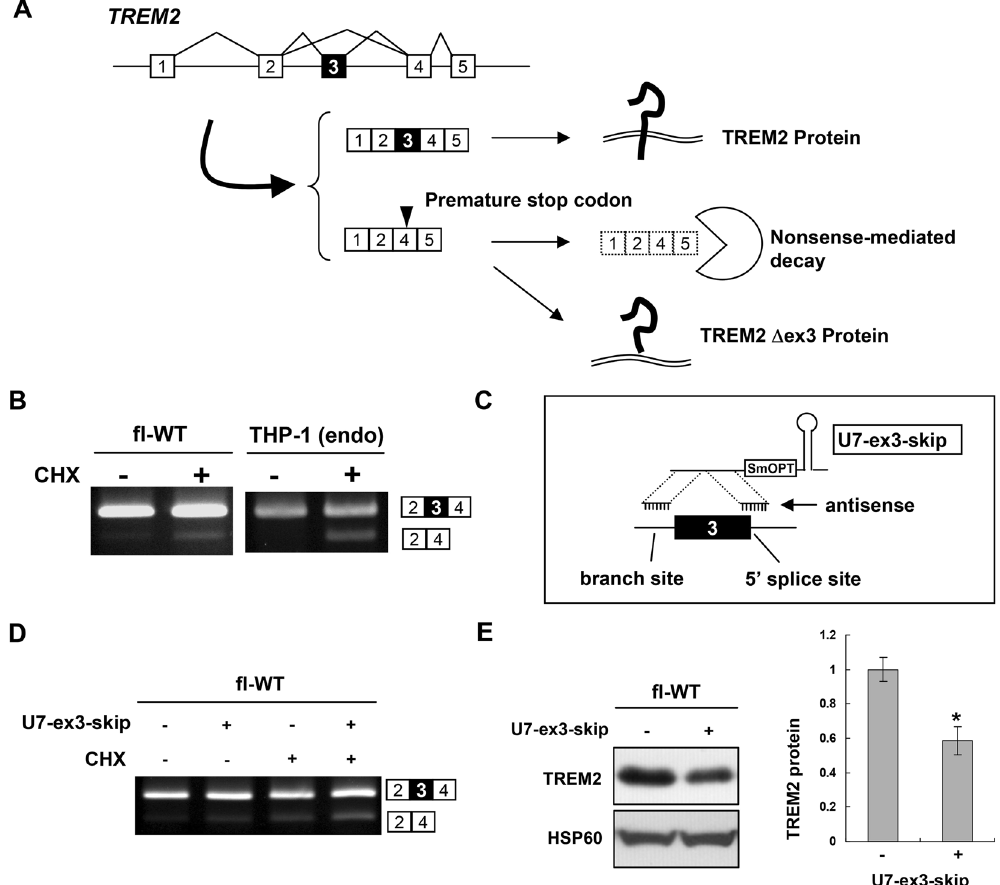
Figure 5. Exon 3 splicing of TREM2 is a determinant of its protein expression. ( A ) Schematic model of TREM2 exon 3 splicing. Exon 3 inclusion leads to expression of full-length TREM2 protein. Exon 3 skipping would result in either expression of a TREM2 isoform lacking exon 3 or degradation of mRNA via nonsense- mediated mRNA decay (NMD) due to production of a premature termination codon in exon 4. ( B ) Exon 3 is alternatively spliced in THP-1 cells. The splicing patterns of TREM2 in fl-WT and THP-1 cells with or without cycloheximide treatment, an NMD inhibitor, are shown. ( C ) Schematic illustration of U7-ex3-skip containing antisense sequences to both the branch point of intron 2 and exon/intron junction of exon 3. ( D ) fl-TREM2 (WT) cells were treated with U7-ex3-skip and/or CHX and the splicing patterns were analyzed by RT-PCR. The exon 3-skipped pattern was increased by U7-ex3-skip and further enhanced by CHX, suggesting that some of the spliced products of exon 3 skipping were degraded by NMD. ( E ) Western blot analysis of TREM2 expression in fl-WT cells with or without transfection of U7-ex3-skip (left panel). The bar chart shows the quantification of the western blot results (mean ± SE). * P = 0.003 in a two-tailed t -test (n = 6). Original gel images and western blot data are shown in Supplementary Fig.